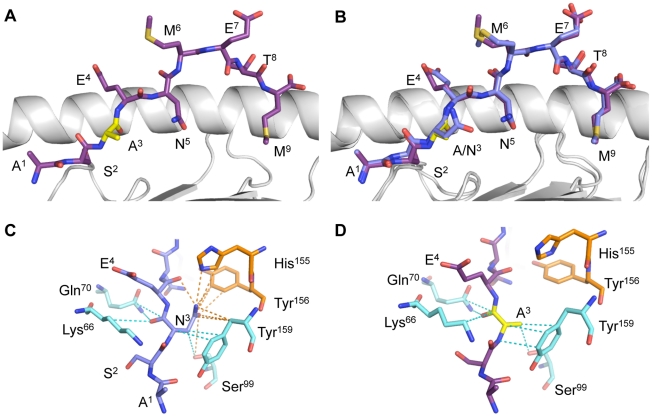
Structure of the DbNP366–374 and DbNPN3A complexes.The H2Db molecule is in a cartoon representation with the α1-helix on the back and the α2-helix removed for better clarity. The peptide is represented in stick conformation with the C terminus on the right. (A) The NPN3A is in purple and (B) the NP366 in blue, with the p3 mutation in yellow. (B) Overlay of the peptide-binding cleft for H2DbNP366 and H2DbNPN3A with the α1-helix on top and the α2-helix on the bottom. (C) Contacts with the H-2Db molecule by (C) P3N in NP366 and (D) P3A in NPN3A. The Asn3 mutation to alanine abolishes contacts between the P3 residue of the peptide with His155 and the Tyr156 of the H-2Db.